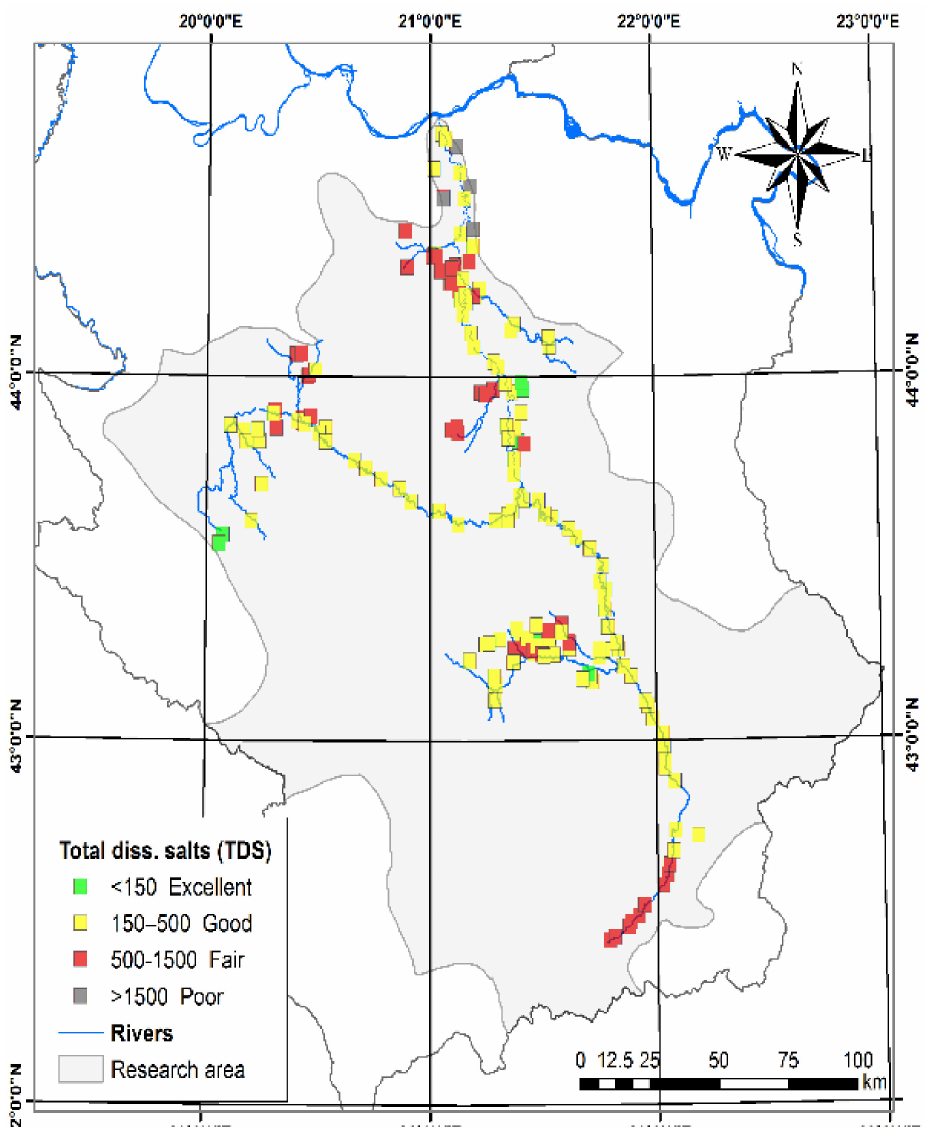
Figure 5. Spatial distribution maps of